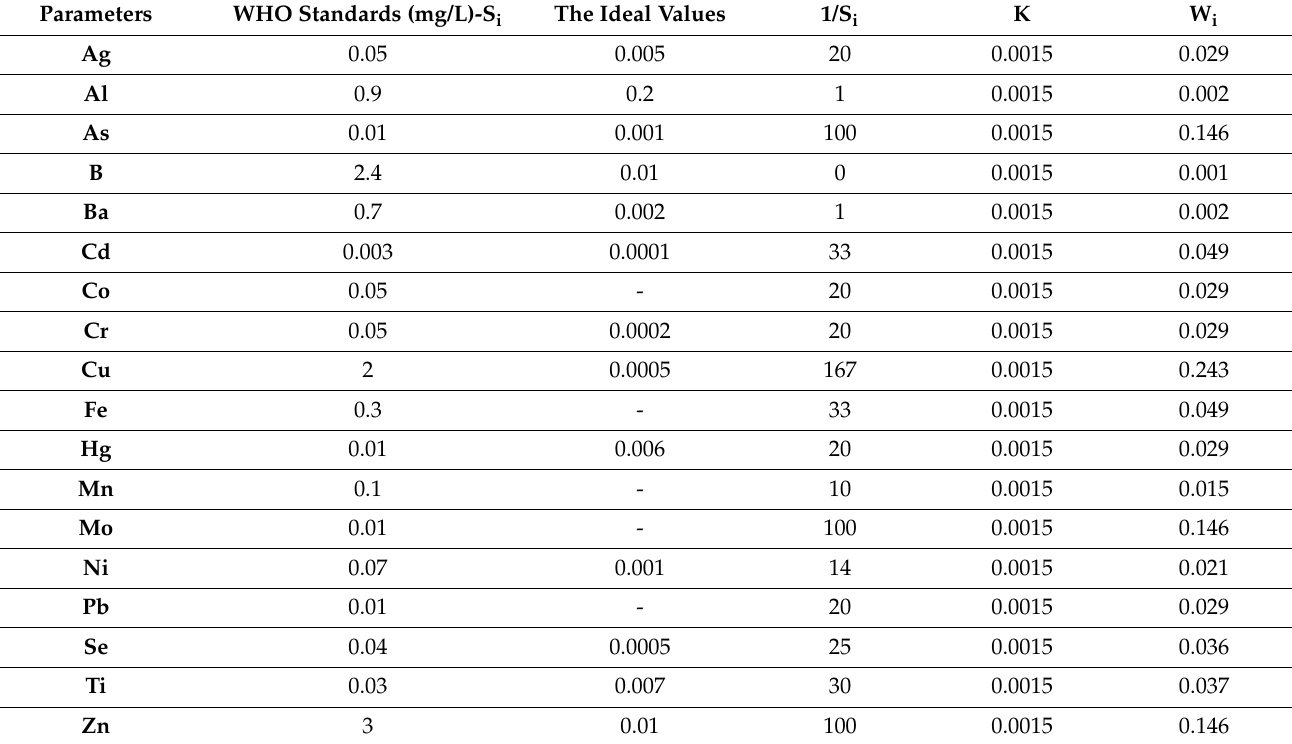
Table 4. Unit weight calculation of the heavy metal evaluation index (HEI).